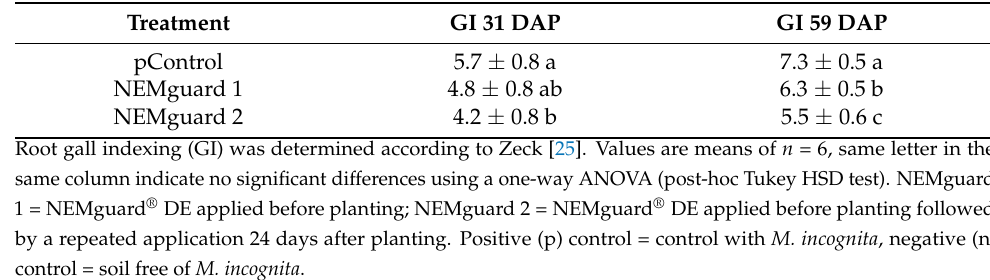
Table 3. Height, fresh and dry weights of tomato plants 31 days after planting into Meloidogyne incognita infested soil treated with NEMguard ® DE.